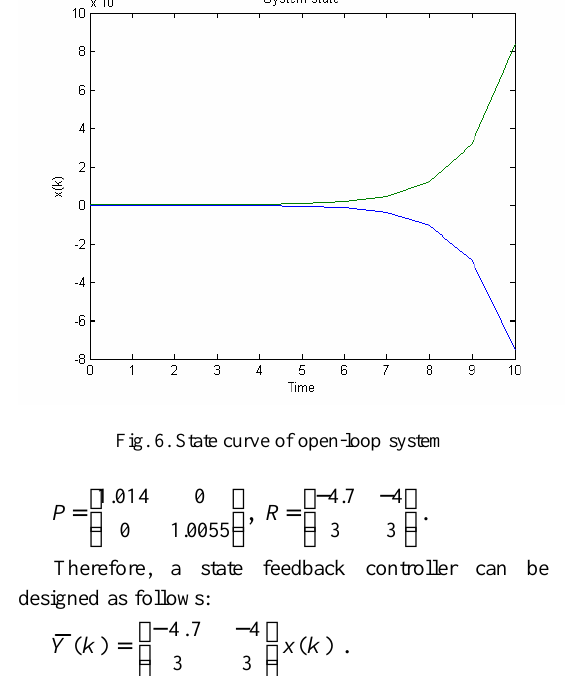
Fig. 6. State curve of open-loop system 1.014 0 P 01.0055